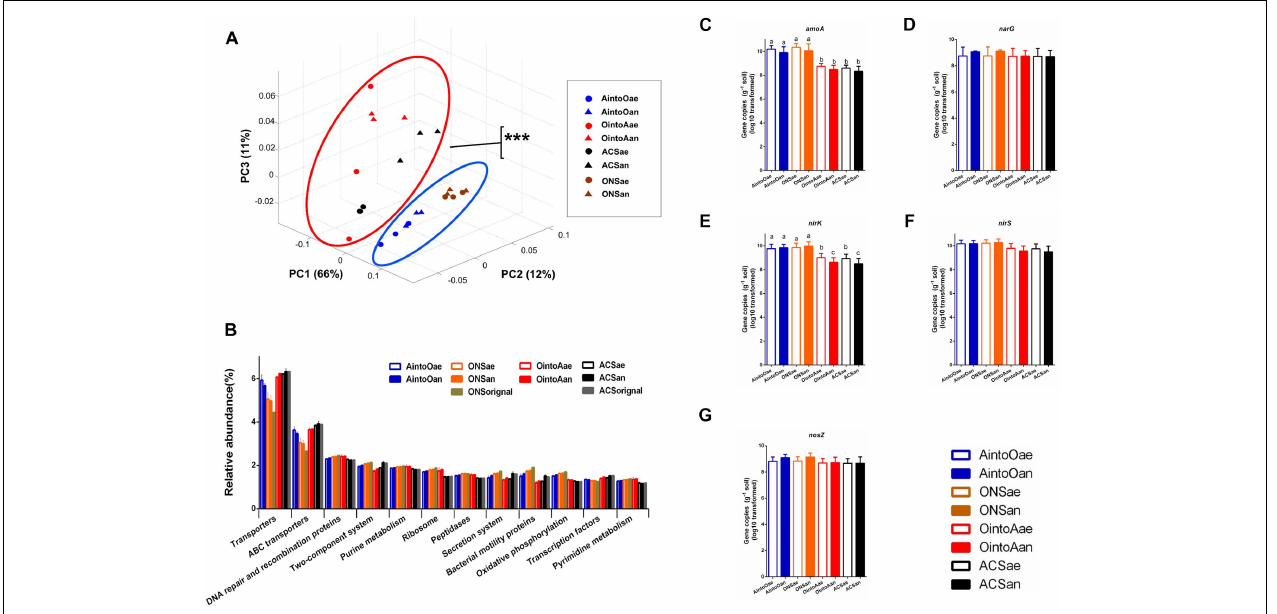
FIGURE 3 | Predicted bacterial community biological function in soil treatments based on PICRUSt, according to both 16S rRNA gene sequencing data and the copy number of genes involved in nitrogen cycling within a gram of soil after long-term incubation. (A) PCoA of soil bacterial biological functions based on the Bray-Curtis distance according to KEGG module predictions in conjunction with the 16S rRNA gene sequencing data. The percentage of the variation explained by the plotted PCs is shown in parentheses. MANOVA analysis indicated significant difference between the circled clusters ( ∗∗∗ P < 0.001). (B) Relative abundance of principal functions by PICRUSt predictions via a KEGG subsystem analysis of samples. All of the data are shown as the means ± standard deviations. The columns and error bars represent the means and standard deviations, respectively. (C–G) Copy number of genes involved in nitrogen cycling in the samples. (C) amoA gene, (D) narG gene, (E) nirK gene, (F) nirS gene, and (G) nosZ gene. One-way ANOVA was used to analyze variations among all the treatments. Different small letters indicate significant differences at the P < 0.05 level, and no significant differences were observed among the soil incubation samples for the narG , nirS, and nosZ genes.